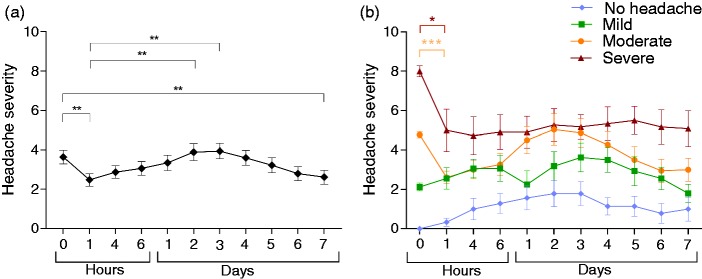
Headache severity following lumbar puncture, mean ± standard error of the mean (SEM). (a) Whole cohort; (b) cohort classified by baseline headache severity. NRS: numeric rating scale.*p < 0.05, **p < 0.01, ***p < 0.001 (Wilcoxon signed-rank test).